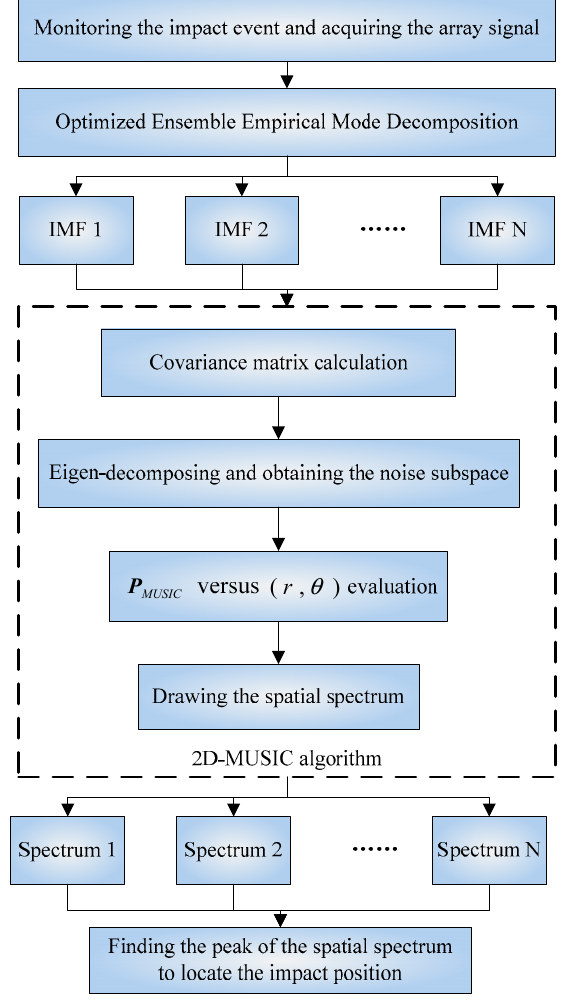
Figure 2. The impact localization process.